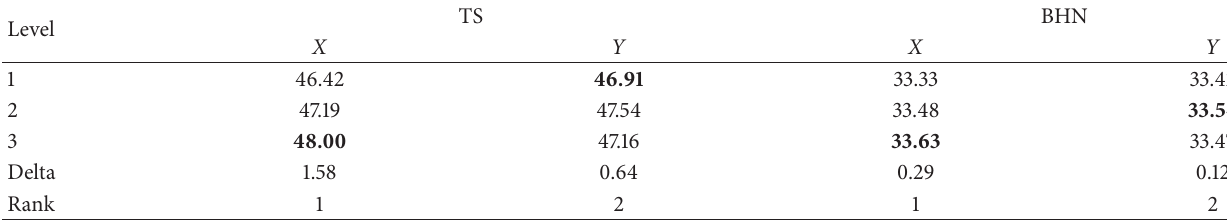
Table 6: Taguchi analysis: TS & BHN versus X , Y of Al6061/Al 2 O 3 /MoS 2 .